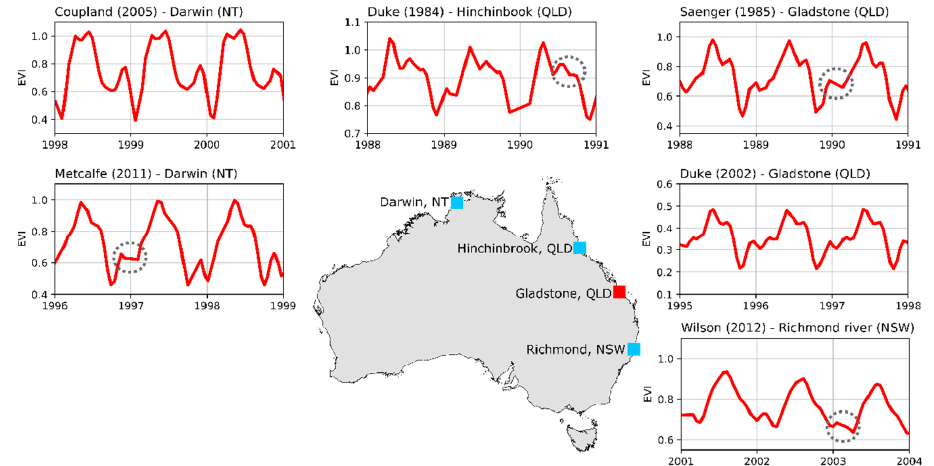
Figure 4. Apparent phenology for each study site. Grey dashed circles show examples of year-to-year variations in the apparent phenology. Blue squares represent locations where only published literature was used, while the red square represents the location of the field data site and where published literature was used.